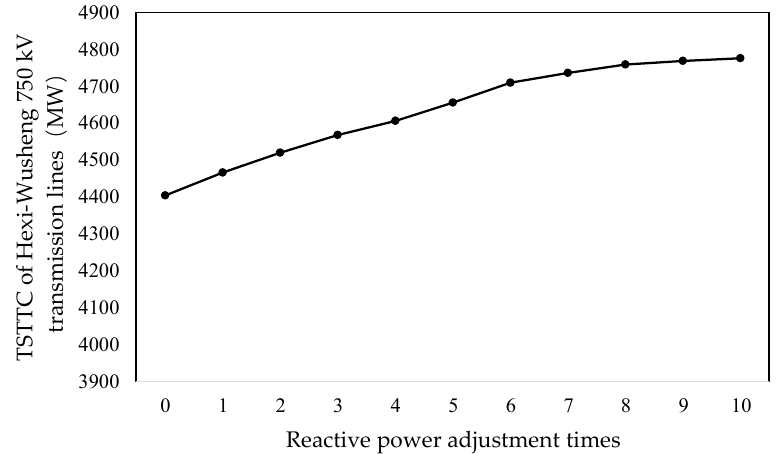
Table 3. Whole process of reactive power adjustment.